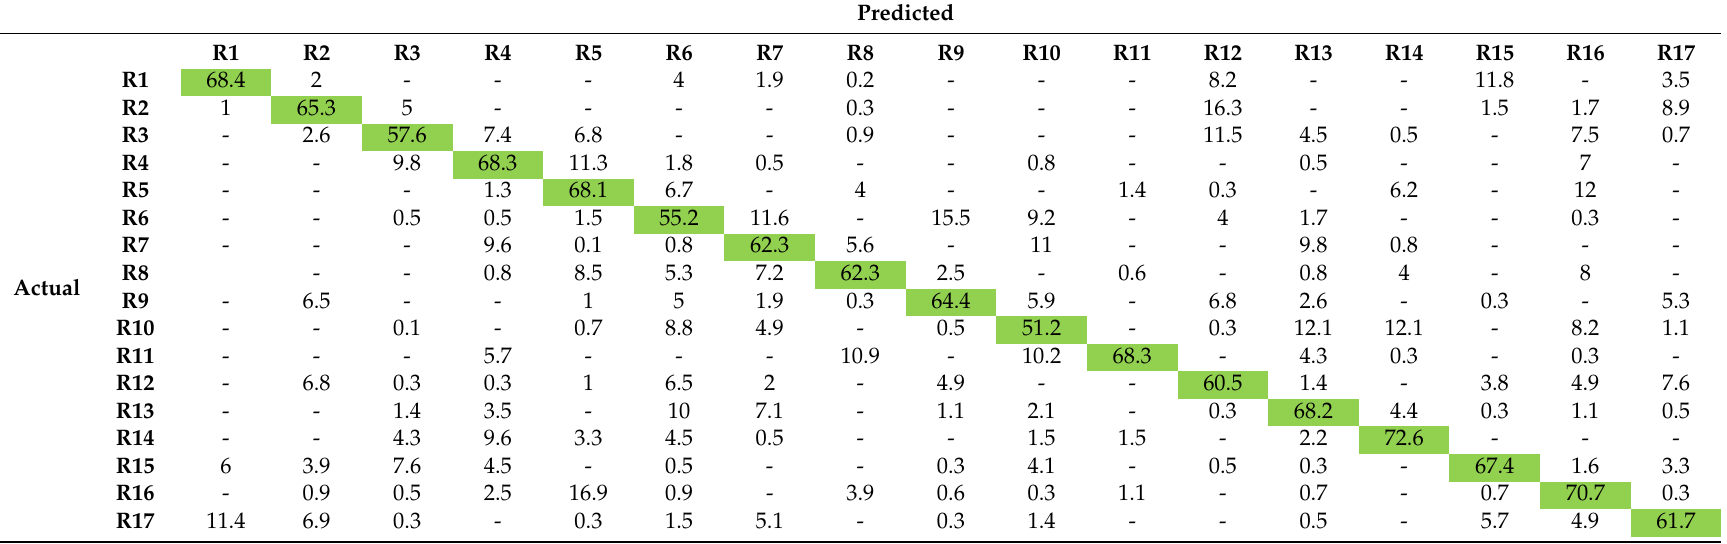
Table 9. Average confusion matrix of previous method [38] from two-fold cross